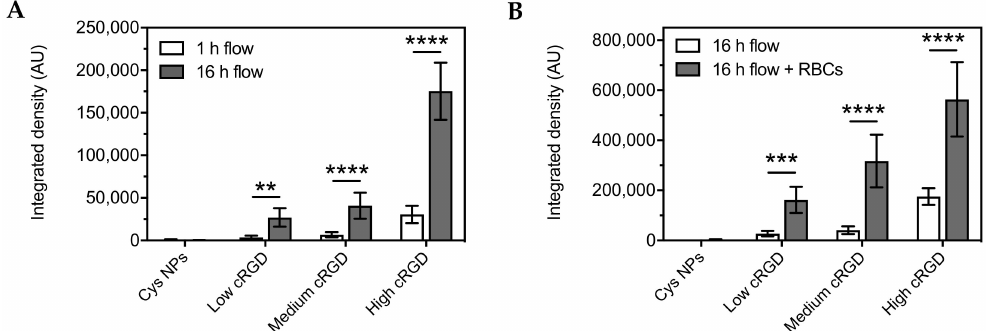
Figure 5. Comparison of the cell association of Cys-NPs and cRGD-NPs of di ff erent ligand densities to HUVECs at 37 ◦ C under flow (shear rate 300 s − 1 ) at di ff erent conditions. ( A ) Cell association after 1 or 16 h of incubation in EBM-2 medium. ( B ) Cell association after 16 h of incubation in EBM-2 medium with and without washed RBCs. The fluorescent signal for the NPs is reported as integrated density (n = 10). Data (mean ± SD) were analyzed by two-way ANOVA followed by Sidak’s multiple comparison test; ** p -value < 0.01, *** p -value < 0.001 and **** p -value <